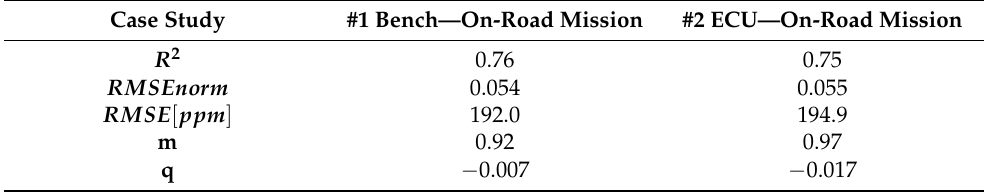
Table 9. Performance prediction results over on-road test driving mission.